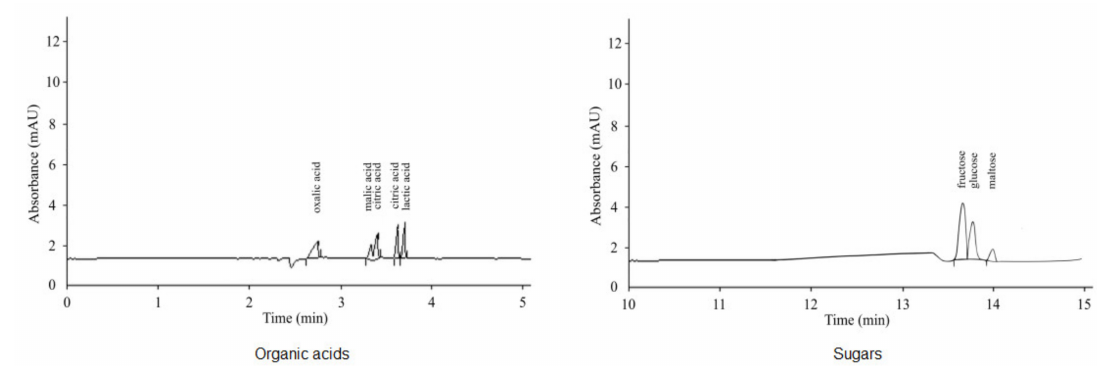
Figure 7. Electrophoregrams of a standard mixtures of organic acids (40 mg L − 1 each) and sugars (500 mg L − 1